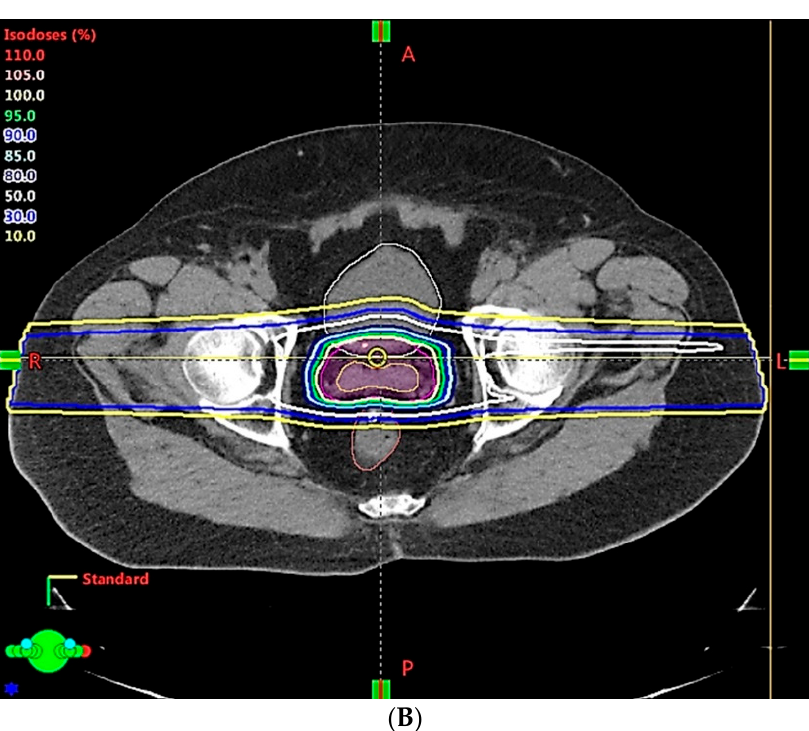
Figure 2. Isodose distribution comparison of two different proton therapy techniques: conventional passive scattering ( A ) and modern intensity-modulated proton therapy (IMPT) ( B ). IMPT shows improved dose conformity near critical organs.